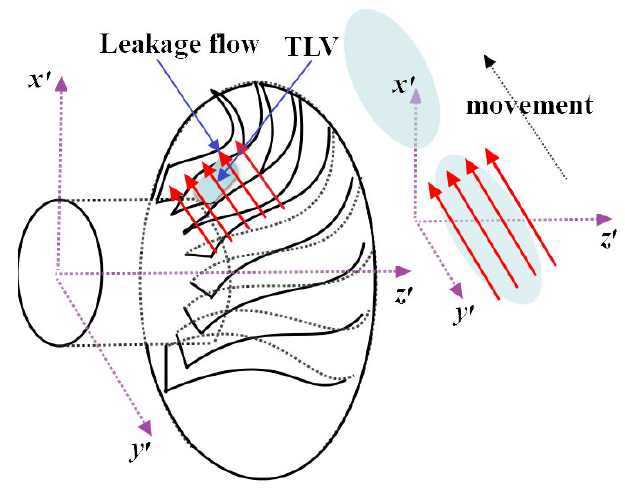
Figure 9. Schematic of the leakage flow effect.